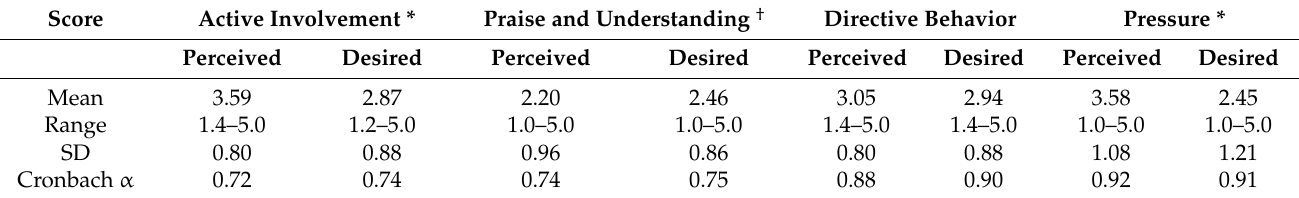
Table 1. Perceived and desired parental involvement in sports activity by children. Scores are presented as mean, range (1–5), and standard deviation (SD).